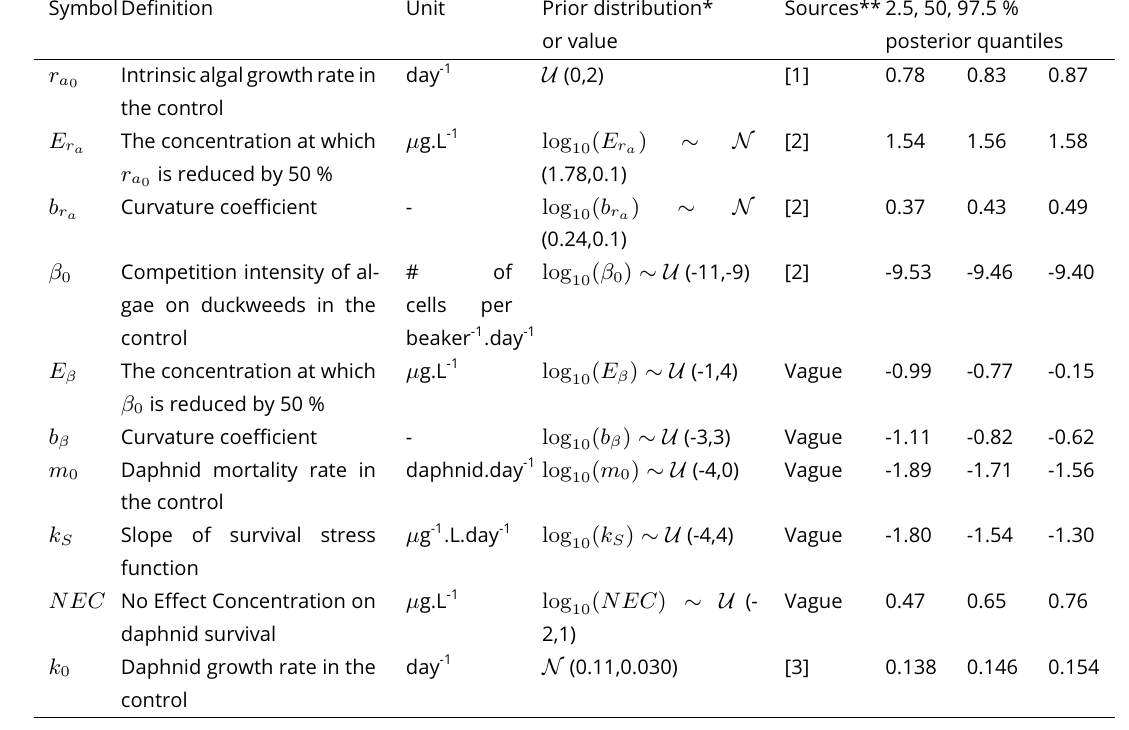
Table 1. Parameters of